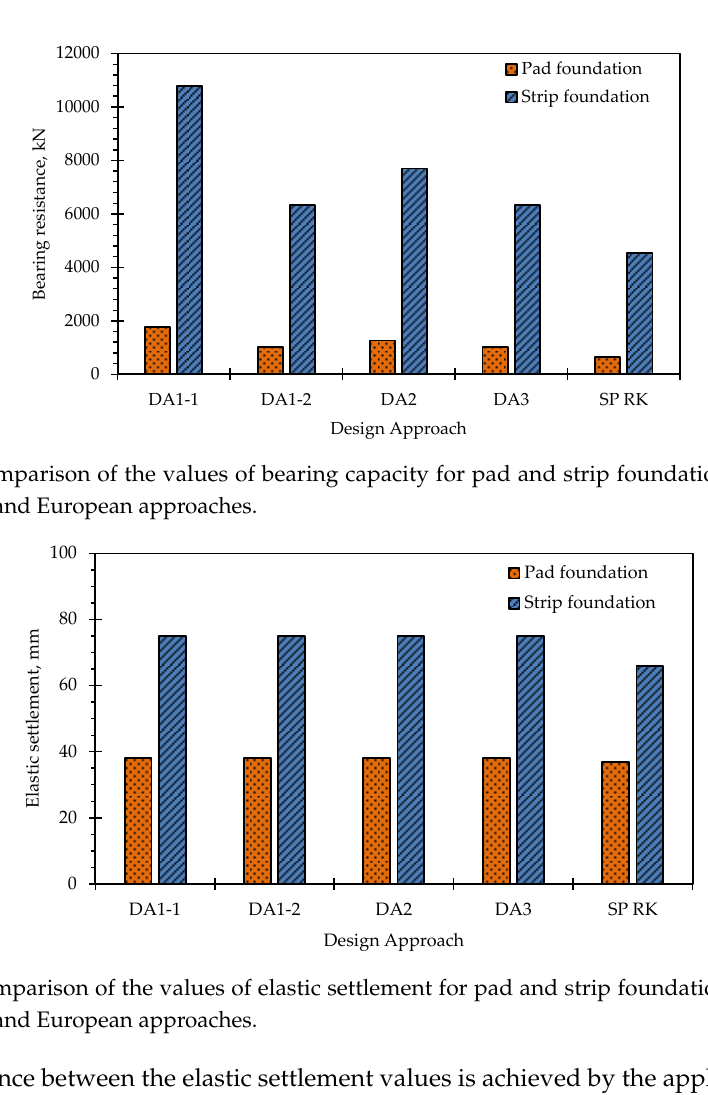
Figure 7. Comparison of the values of over-design factor for pad and strip foundations adhering to Kazakhstani and European approaches. 5. Summary and Conclusion